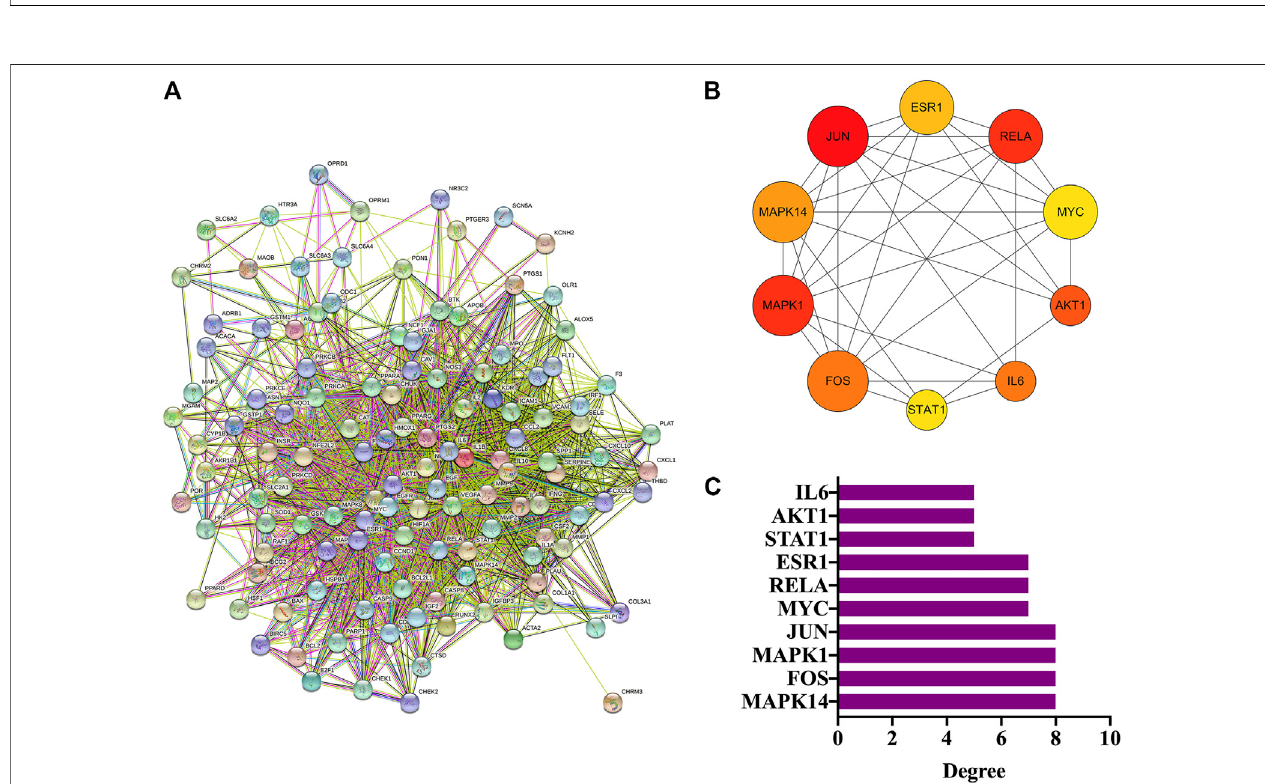
FIGURE 4 | PPI network analysis and hub genes. (A) PPI network analysis. (B) Screening of hub genes. (C) Degree value of hub genes.